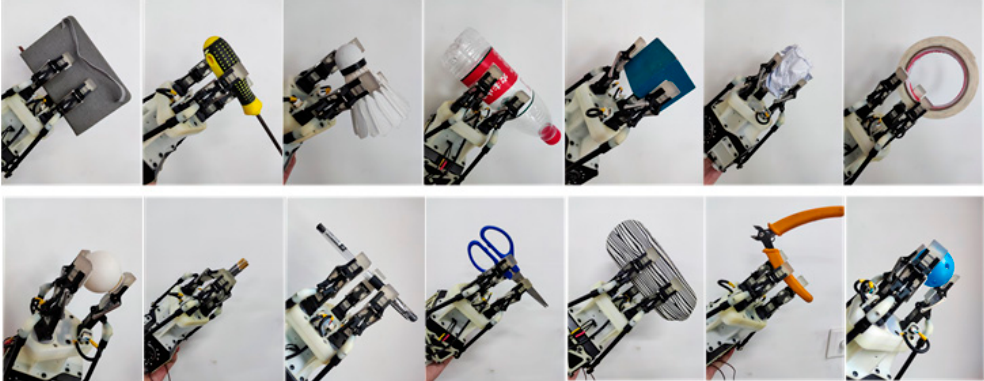
Figure 14. Gripping objects of different orientations.